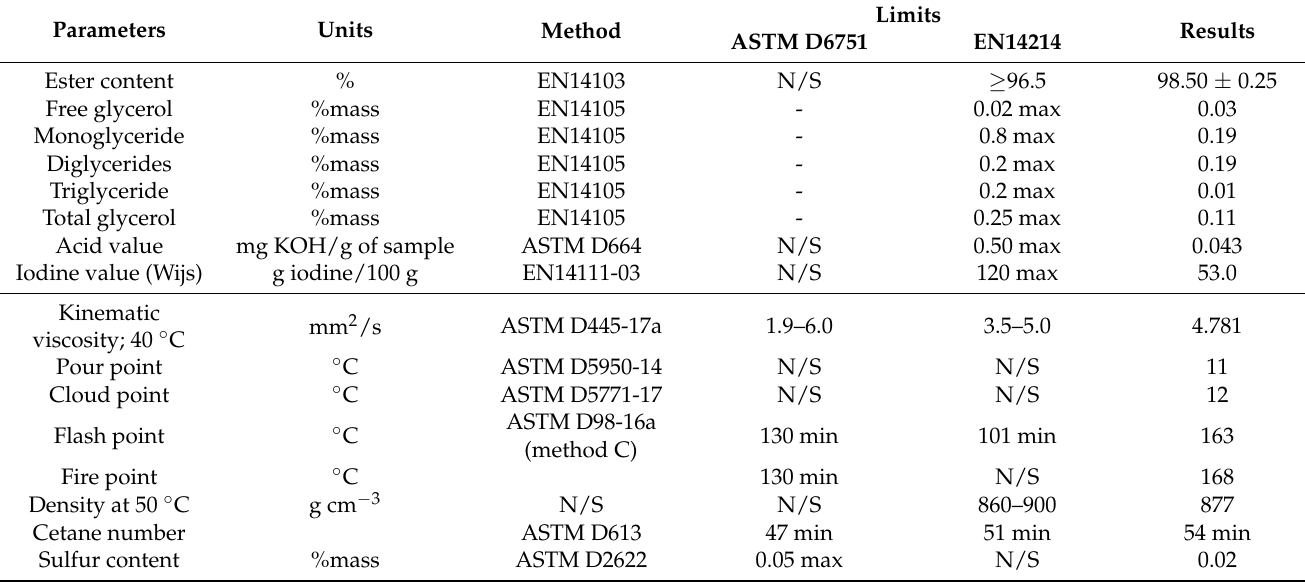
Table 2. Characterization of biodiesel product from refined palm oil